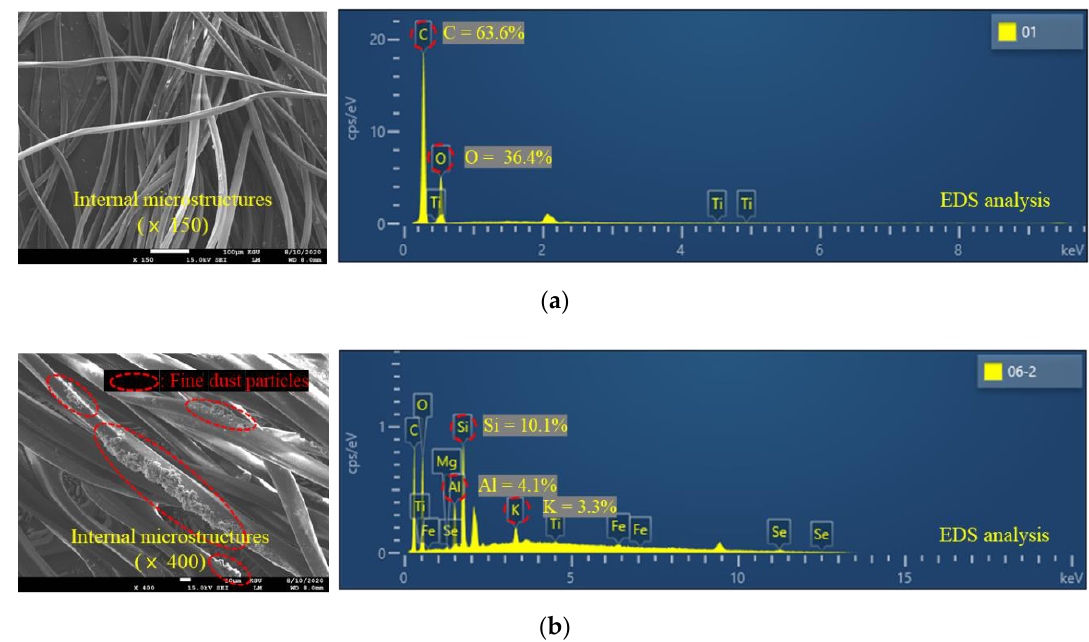
Figure 8. SEM images and EDS spectra of the uncoated textile fibers. ( a ) Before adsorption of the fine dust particles. ( b ) After adsorption of the fine dust particles.